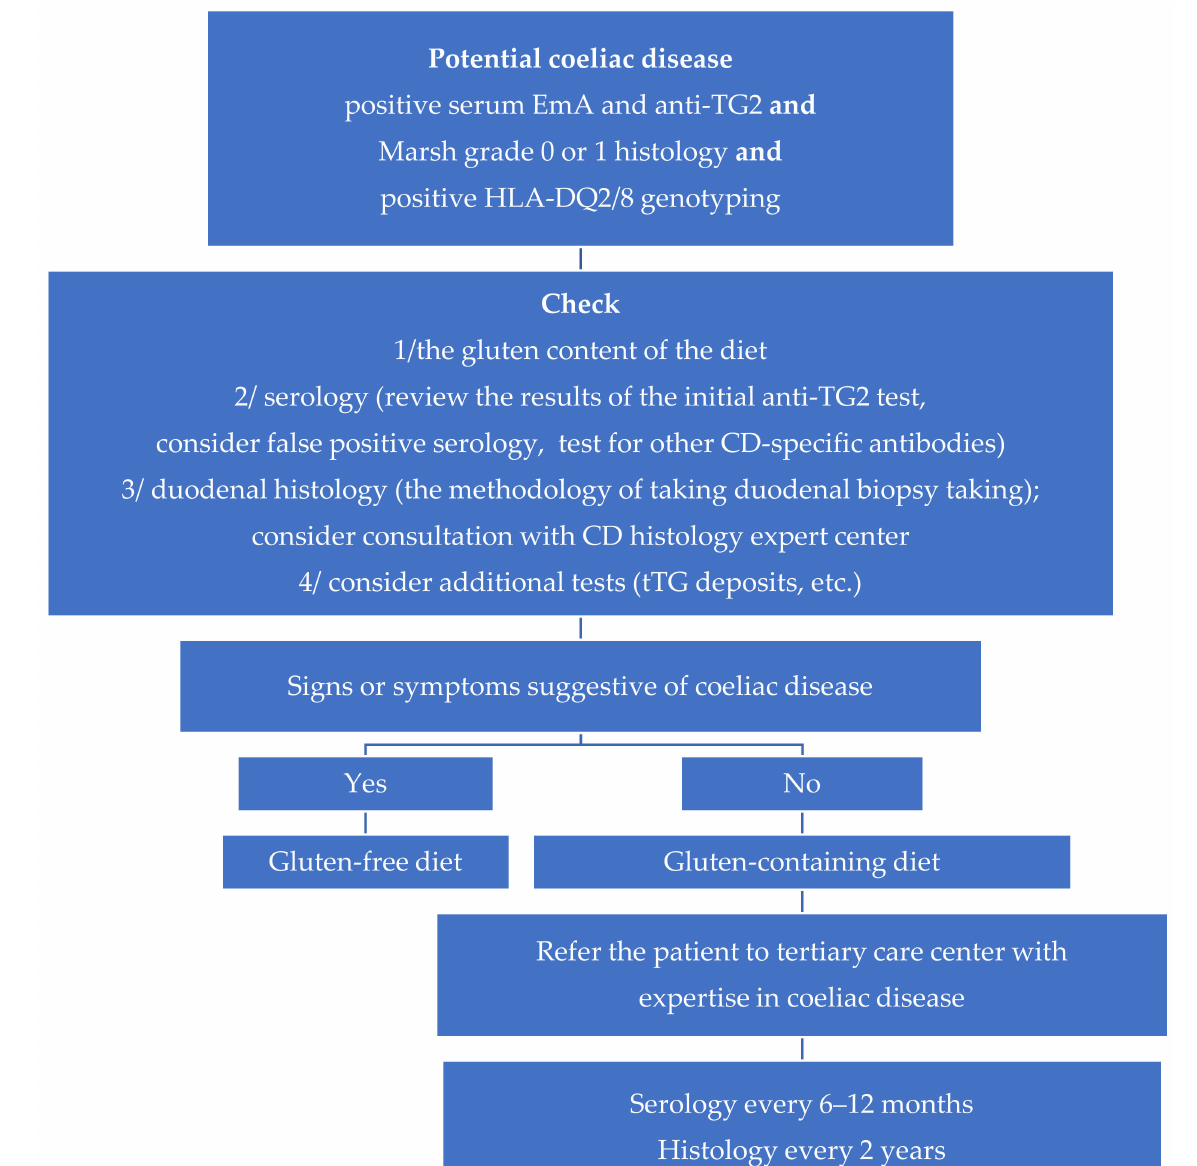
Figure 1. A proposed rational approach to treating patients with potential coeliac disease. Funding: The research received no external